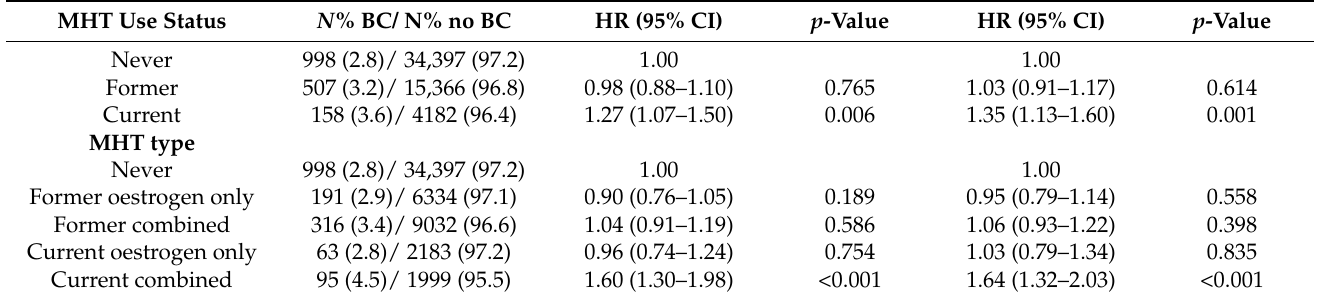
Table 5. MHT status and type of MHT and breast cancer